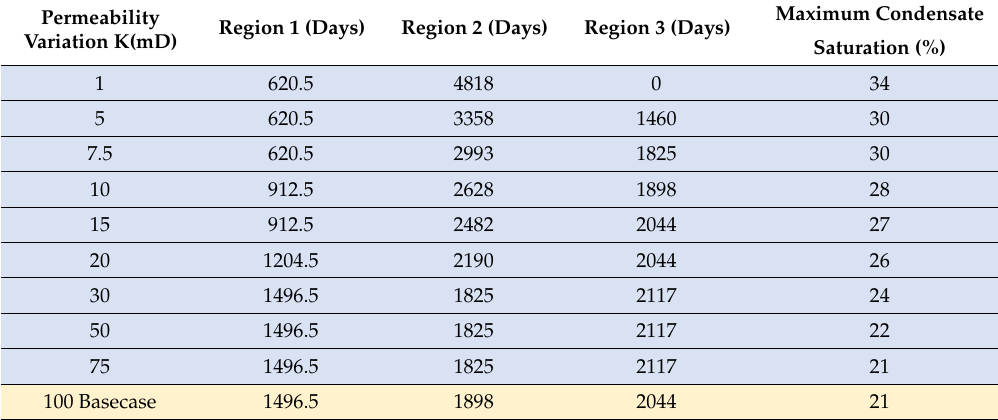
Table 1. Summary of the duration of each region and maximum condensate saturation for each case of permeability variation: global analysis.